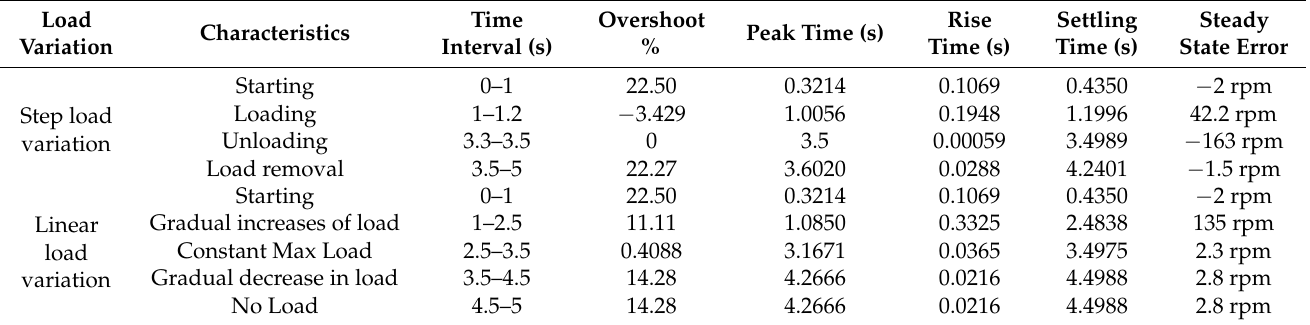
Table 2. PI Controller